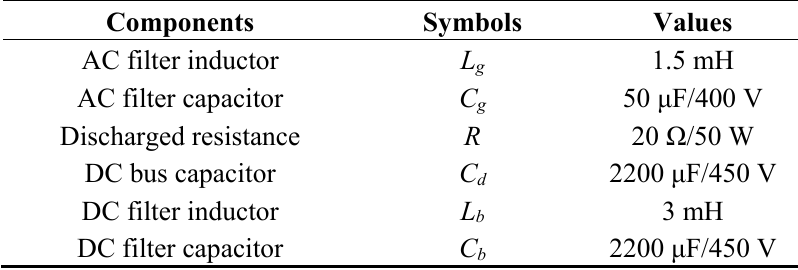
Table 1. The component values for proposed